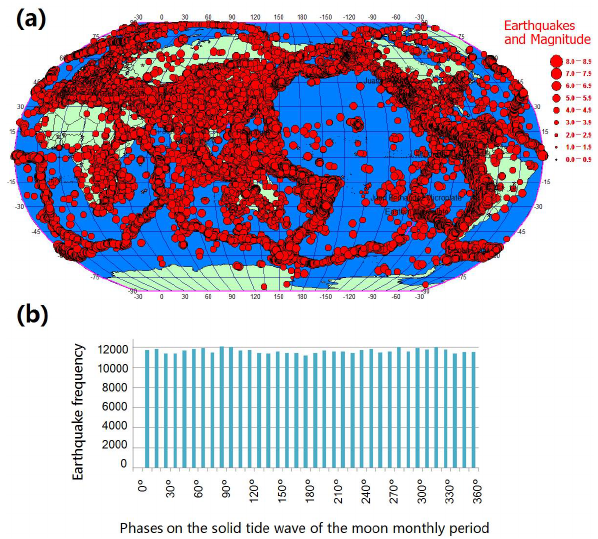
Fig. 1. Global epicenter distribution and earthquake frequency rela- tive to the lunar solid earth tides. (a) Epicenter distribution of world- wide earthquakes. (b) M s ≥ 4 earthquake frequency distribution relative to the monthly lunar solid tide phases using 420747 earth- quakes. The difference between the lunar celestial longitude and the solar celestial longitude is used for counting the number of earth- quakes.